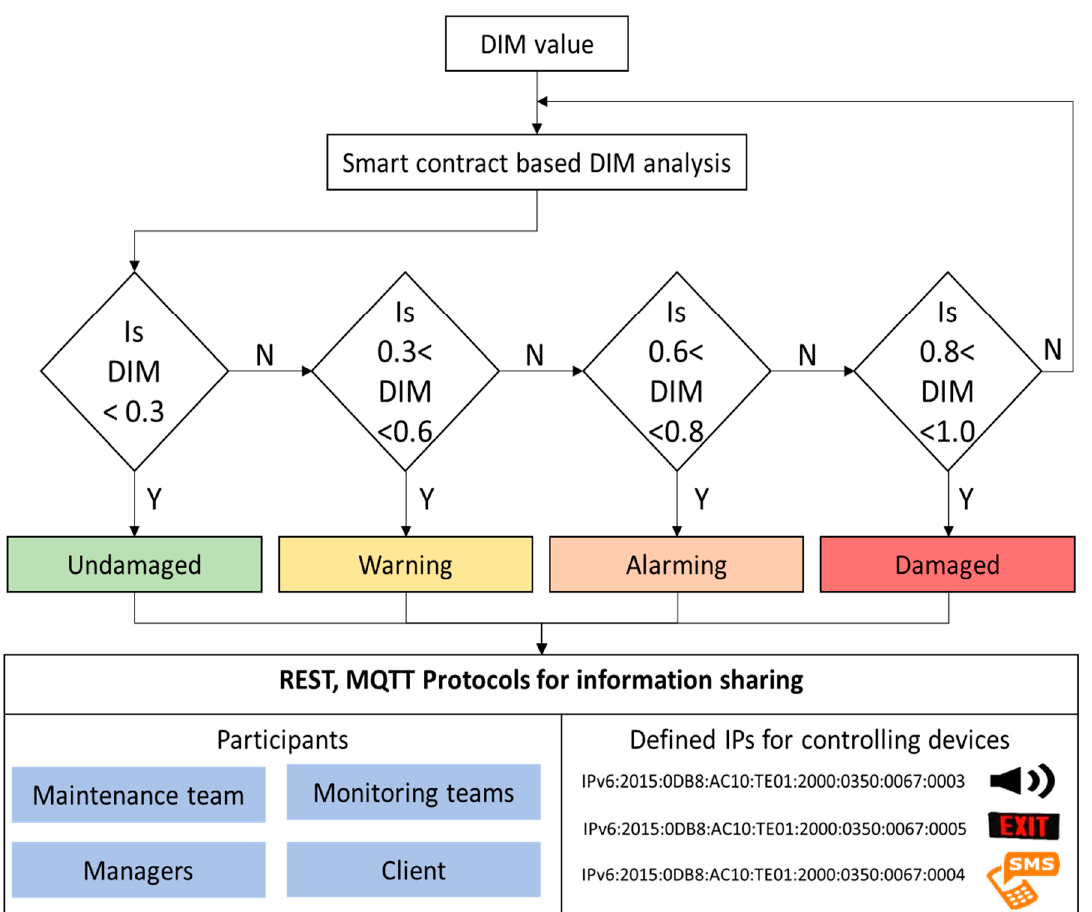
Figure 3. Flow chart of the smart contract and IoT network for transparent information sharing for the selected data of an underground coal mine.